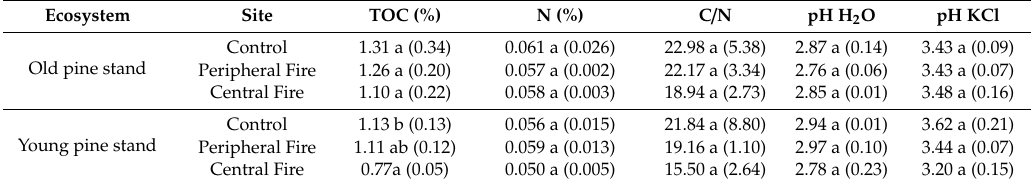
Table 1. Selected chemical properties of soil two years after a fire under young and old pine stands taken from control, peripheral and central fire sites; mean values ( n = 3) with standard deviation (SD) in brackets. TOC—total organic carbon, N—nitrogen,